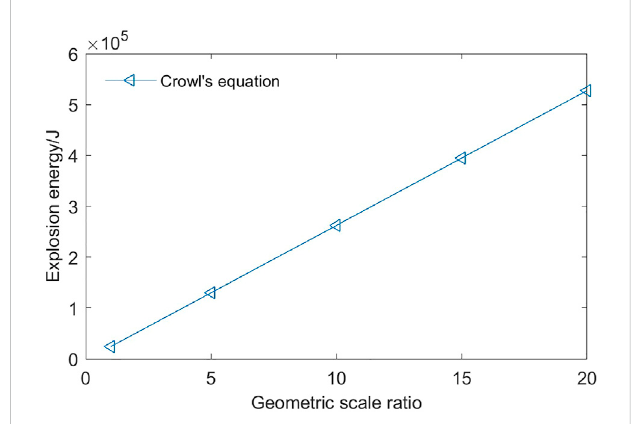
FIGURE 8 Overpressure for envelopes at different pressure differences.